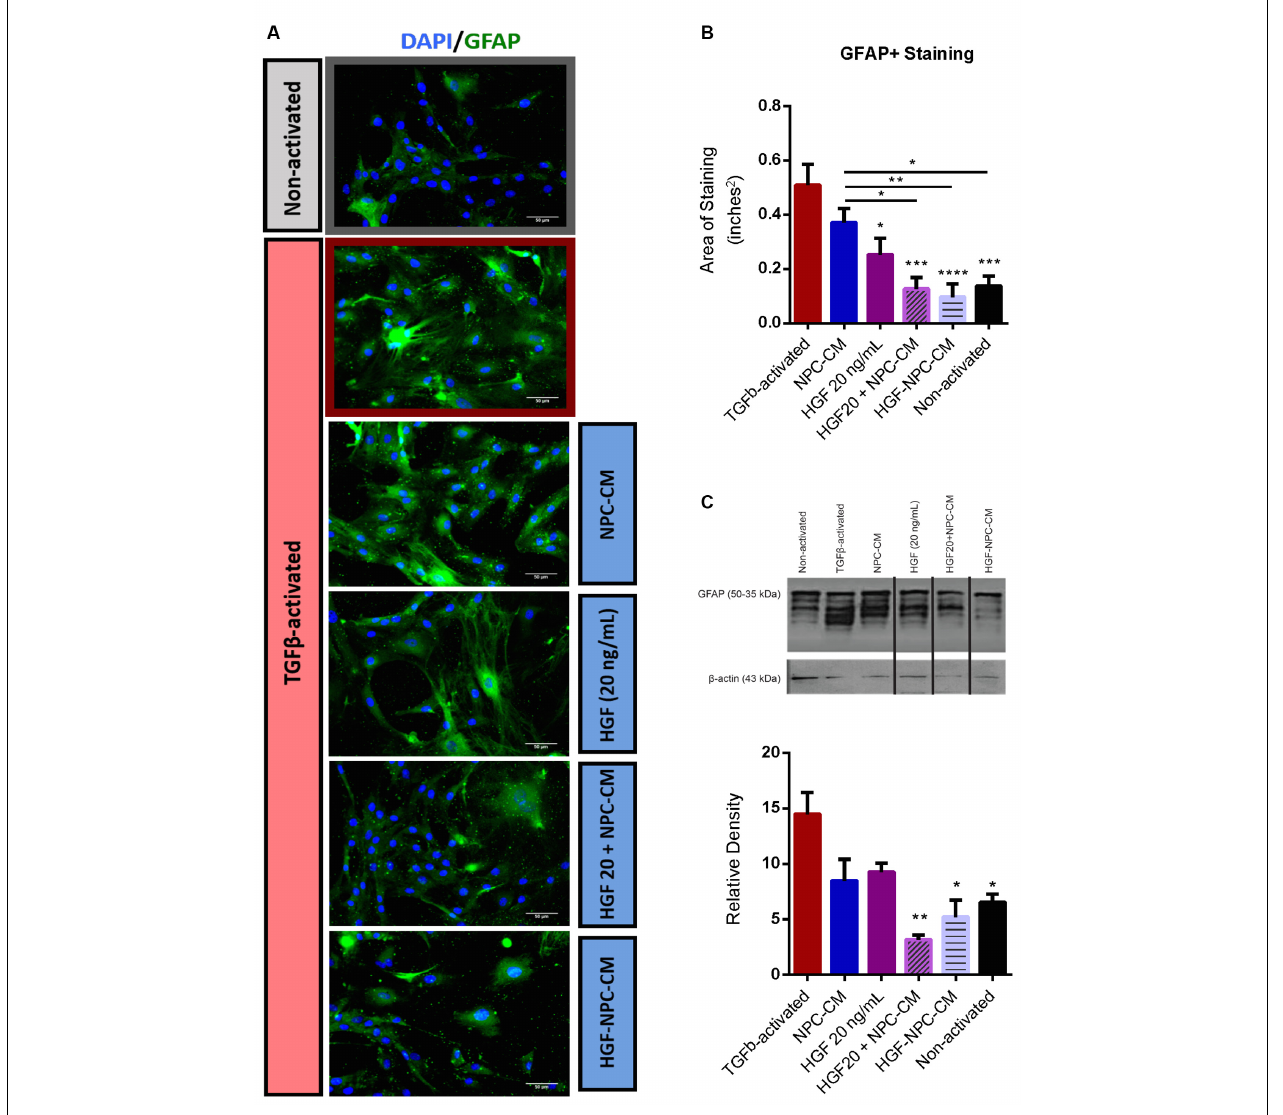
FIGURE 2 | Combinatorial treatment of reactive astrocytes with HGF-enhanced NPC-CM demonstrates reduced glial fibrillary acidic protein (GFAP) expression. (A,B) Immunostaining of non-activated and TGF β -induced reactive astrocytes with reactivity marker GFAP (green) and DAPI (blue). TGF β -activated astrocytes demonstrate a significant increase in GFAP expression relative to non-activated astrocytes. Subsequent administration of HGF alone as well as combinatorial treatment (preconditioned and concurrently applied HGF and NPC-CM) demonstrated a significant reduction in GFAP expression relative to TGF β -activated controls. Combinatorial treatment also proved more effective than NPC-CM alone. Data are expressed as mean ± SEM; one-way ANOVA with Tukey’s post hoc test; * p ≤ 0.5, ** p ≤ 0.01, *** p ≤ 0.001, **** p ≤ 0.0001. (C) Western blot of cell lysate probed with GFAP (bands ranging from 35 to 55 kDa) and β -actin loading control (43 kDa). TGF β -activated astrocytes demonstrate a significant increase in GFAP expression relative to non-activated astrocytes. Only combinatory treatments (preconditioned and concurrently applied) demonstrated a significant reduction in GFAP production relative to TGF β -activated controls. Data are expressed as mean ± SEM; one-way ANOVA statistical analysis with Tukey’s post hoc test was performed; * p ≤ 0.5, ** p ≤ 0.01, *** p ≤